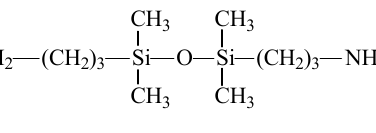
Figure 16. Molecular structure of GAPD.